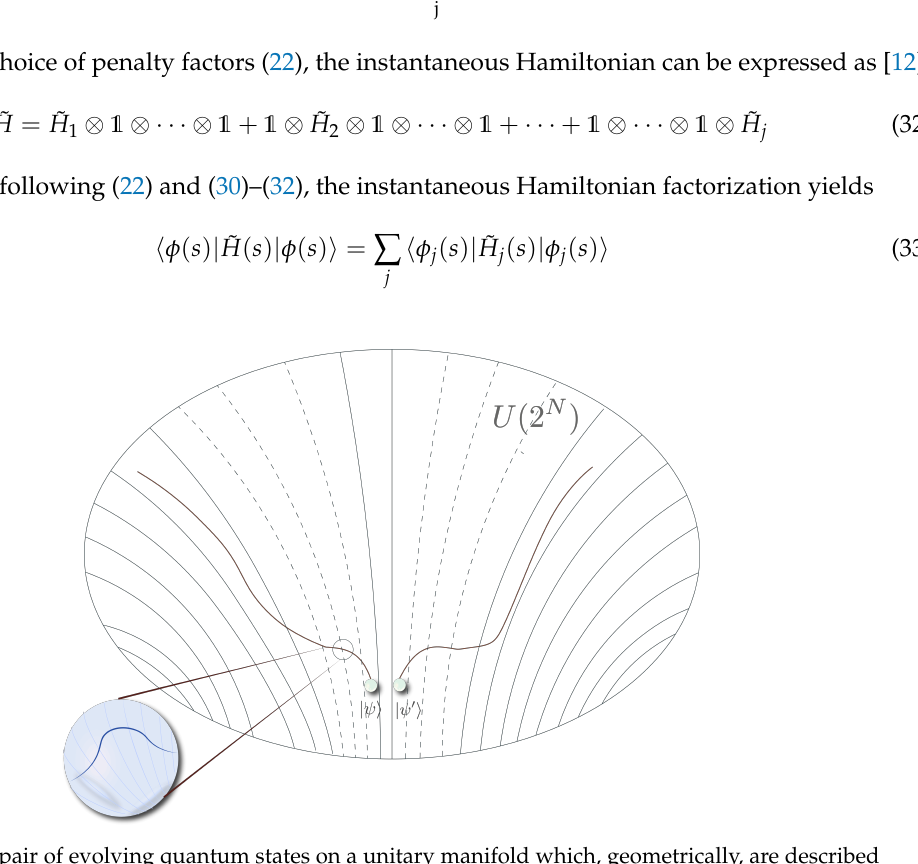
Figure 1. A pair of evolving quantum states on a unitary manifold which, geometrically, are described as geodesics. Initially, the quantum states are arbitrarily close, i.e., low relative state complexity. Due to the chaotic early dynamics, however, their trajectories diverge. Later, for t > t ∗ the distance between the states continues to grow but now linearly in N